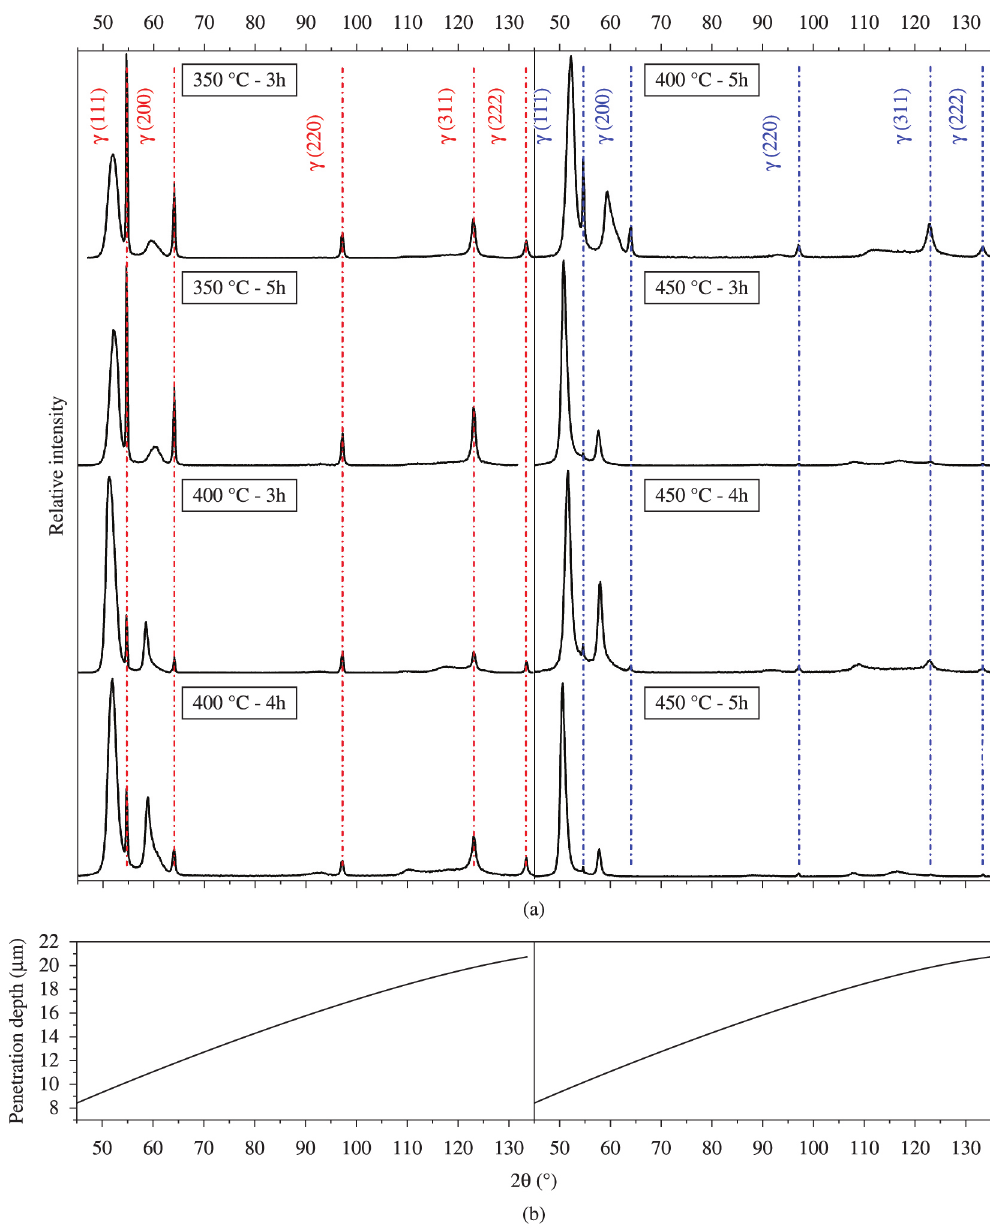
Figure 1. (a) X-ray diffraction patterns of the samples nitrided at different temperatures and times and (b) Synchrotron radiation (6.5keV) penetration depth ( d ) as a function of the diffracted